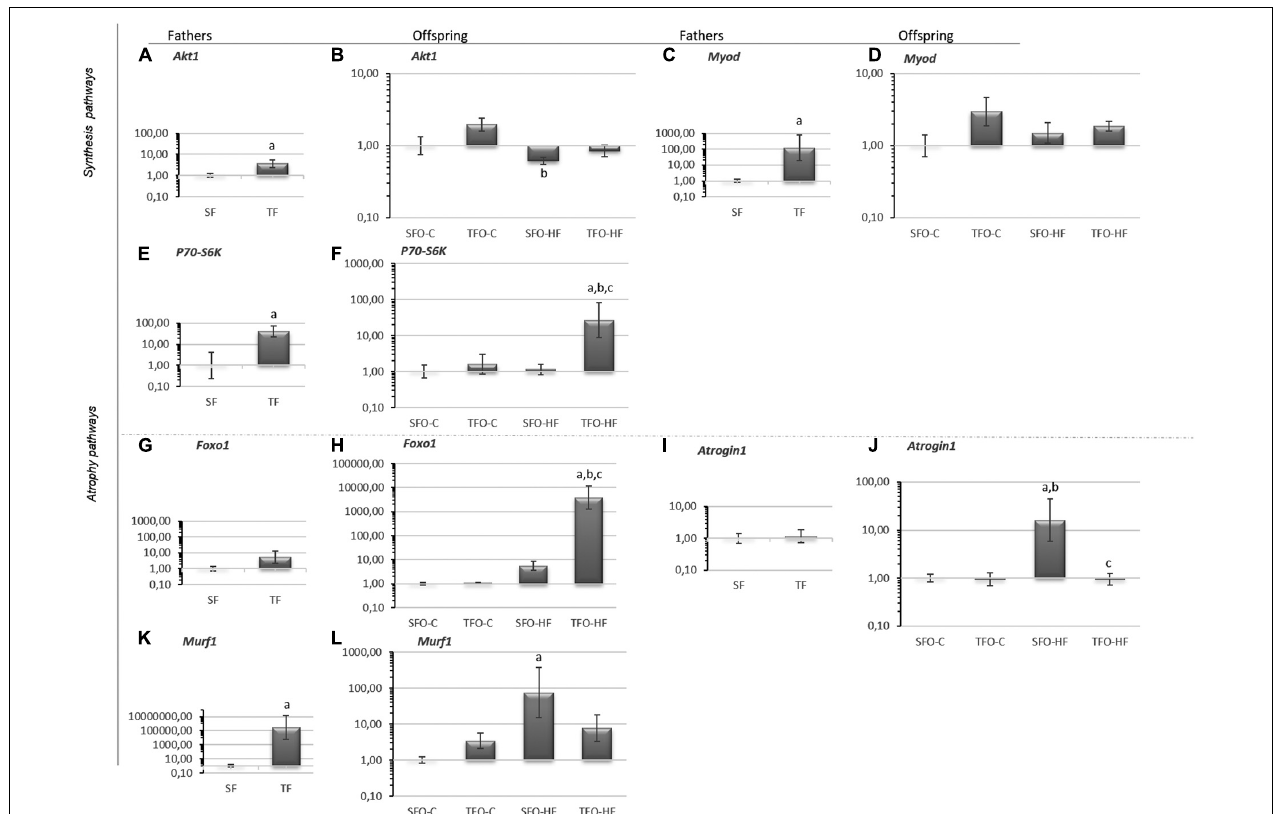
FIGURE 3 | Synthesis and atrophy pathway mRNA levels in the gastrocnemius muscle of fathers and offspring exposed to control diet and HFD. The data are geometric mean ± standard error. The expression level is represented by the 2 − (cid:49)(cid:49) CT . (A,B) Protein kinase B ( Akt1 ). (C,D) Myoblast determination protein 1 ( Myod ). (E,F) Ribosomal protein S6 kinase beta-1 ( P70s6k ). (G,H) Forkhead Box O1 ( Foxo1 1). (I,J) Atrogin 1 ( Atrogin 1 ). (K,L) Muscle RING-finger protein-1 ( Murf1 ). SF, sedentary fathers; TF, trained fathers; SFO-C, offspring from sedentary fathers, exposed to control diet; TFO-C, offspring from trained fathers exposed to control diet; SFO-HF, offspring from sedentary fathers exposed to high-fat diet; TFO-HF, offspring from trained fathers exposed to a high-fat diet. Statistically significant differences compared to: a SFO-C; b TFO-C; c SFO-HF, p ≤ 0.05 ( n = 7 per